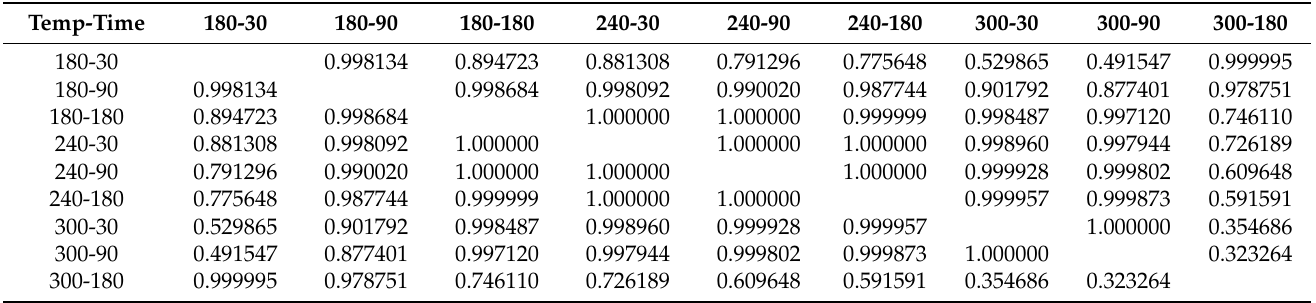
Table A7. Two-way analysis of variance (ANOVA) with post hoc Tukey test for LHV , a bold font signifies a statistically significant difference ( p < 0.05).